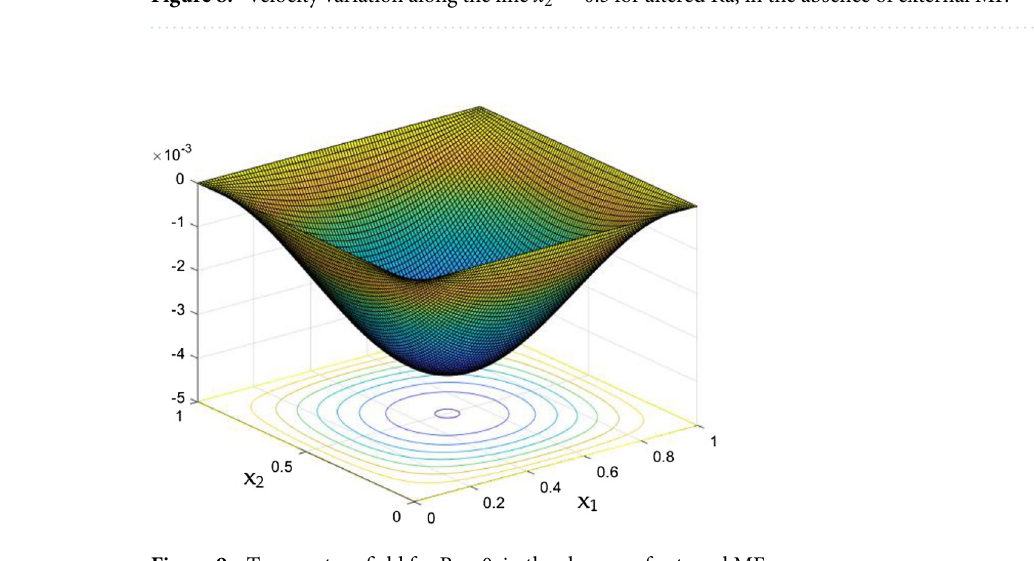
Figure 9. Temperature field for Ra = 0, in the absence of external